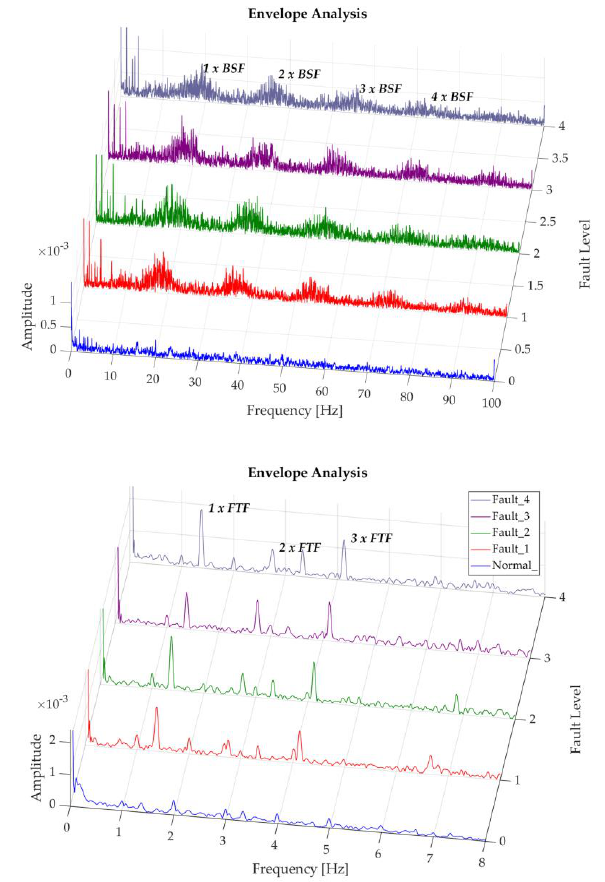
Figure 15. Representation of recordings of rolling element degradation at 200 rpm.